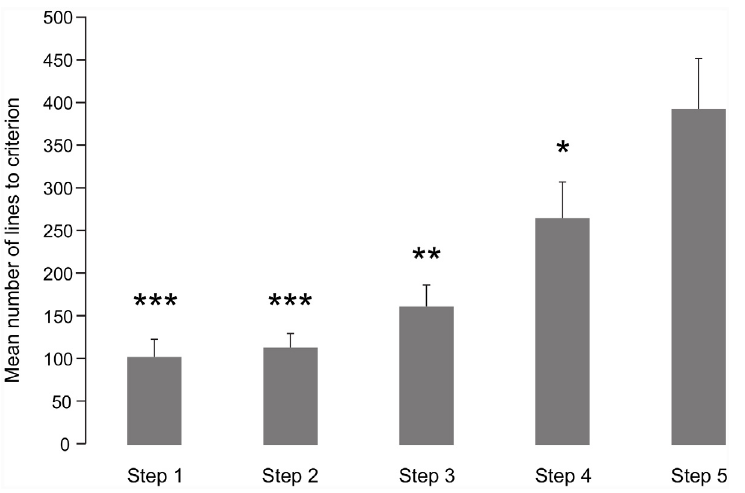
Fig 2. Mean number of trials ( ± S.E.M.) to reach criterion at each step of initial training. Number of dogs in the experimental groups: n = 5 in steps 1 to 3; n = 7 in step 4 and n = 9 in step 5. *** , ** and * : P < 0.001, 0.01 and 0.05 respectively, compared to step 5, with post-hoc Bonferroni tests.